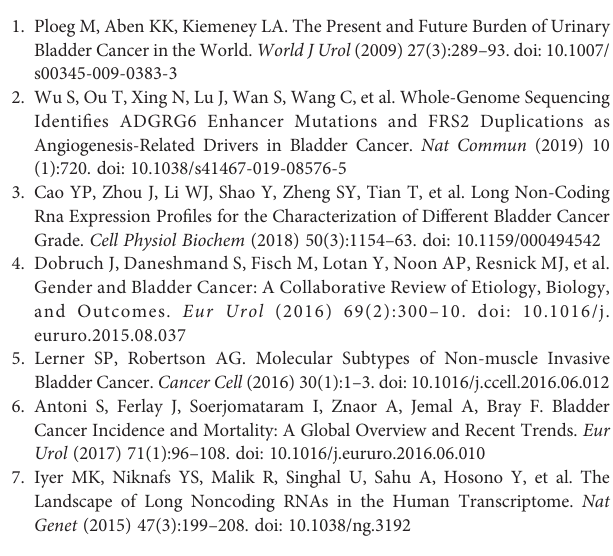
Supplementary Figure 1 | (A – I) Normalized expression level of potential miR- RNA targets in bladder cancer patients retrieved from the GEO datasets (GSE40355). (J) T24 cells were cultured with 5mM DMSO or 5mM 3-MA, MTT assay was used to evaluate cell proliferation levels. Supplementary Figure 2 | T24 bladder cancer cells were cultured with overexpressed SNHG1 or knocking down SNHG1, and the cells were seeded at a density of 4 x 105 cells/well. After 12 h post-treatment, cells were stained with annexin V and propidium iodide and subjected to fl ow cytometric analysis. The result is representative of three independent experiments. Supplementary Table 1 | Primer